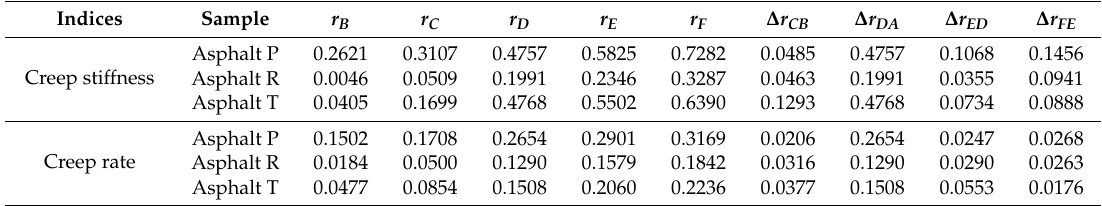
Table 7. r and ∆ r values of creep stiffness and creep rate at − 12 ◦ C.